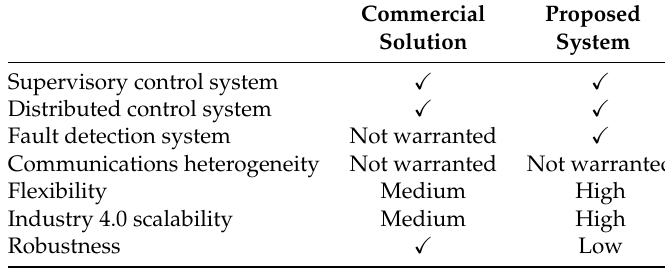
Table 8. General characteristics comparison between commercial supervisory control and data acquisition (SCADA) systems and the proposed